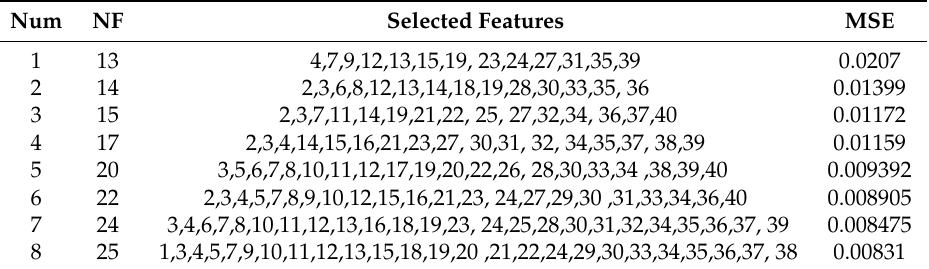
Figure 5. Pareto front derived from UNSW-NB15. Table 3. Pareto Front Details in NSL-KDD